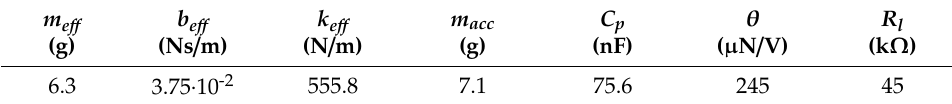
Table 2. 1DOF model parameters of the considered multilayer